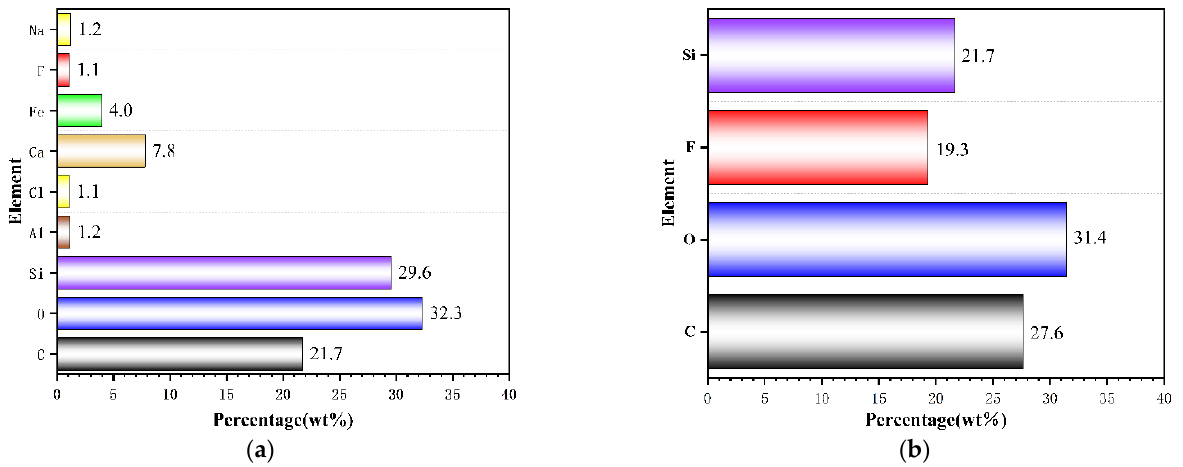
Figure 4. ( a ) Elemental distribution of composite insulator. ( b ) Elemental distribution of FAS-17- modified nano-SiO 2 /PDMS surface.